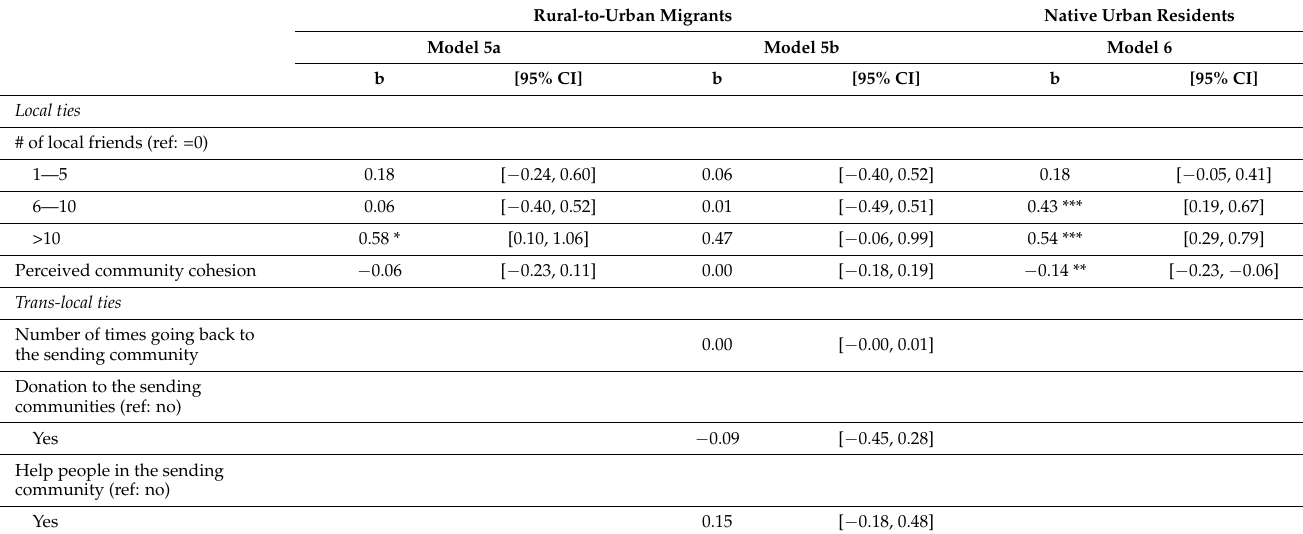
Table 5. The effect of local ties and trans-local ties on alcohol use. Rural-to-Urban Migrants Native Urban